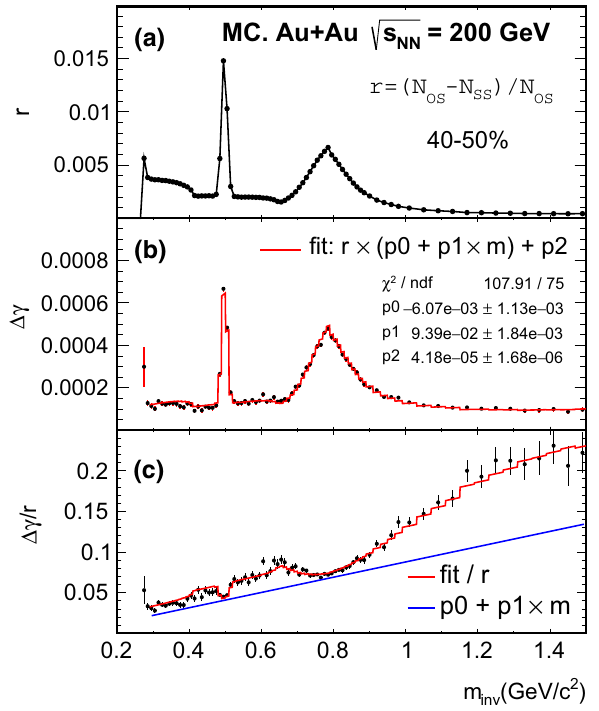
Fig. 3 a r = ( N OS − N SS )/ N SS , b (cid:2)γ , and c (cid:2)γ/ r as a function of m inv from the toy MC simulation of total 200 × 10 6 events. Included are primordial π ± , and K S ,ρ,η,ω resonances, using parameters cor- responding to measurements in Au+Au collisions of the 40–50% cen- trality. A CME signal a 1 = ± 0 . 008 is included